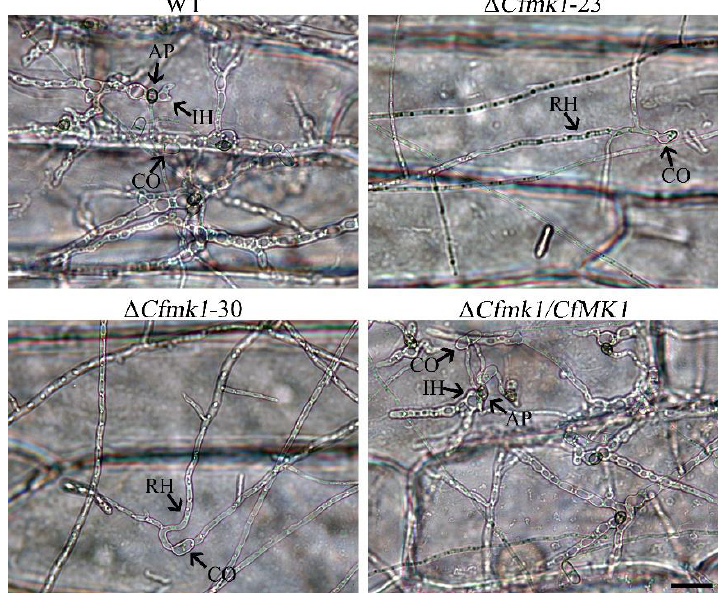
Figure 5. Penetration assays with onion epidermal cells. Extensive invasive hyphae were developed by the WT and Δ Cfmk1 / CfMK1 by 48 hpi. The tenuous running hyphae formed by Δ Cfmk1-23 and Δ Cfmk1-30 failed to penetrate cells, and no invasive hyphae were observed. CO, conidium; AP, appressorium; IH, invasive hypha; and RH, running hypha. Bars = 10 μm.